Question: What form of chart is displayed?
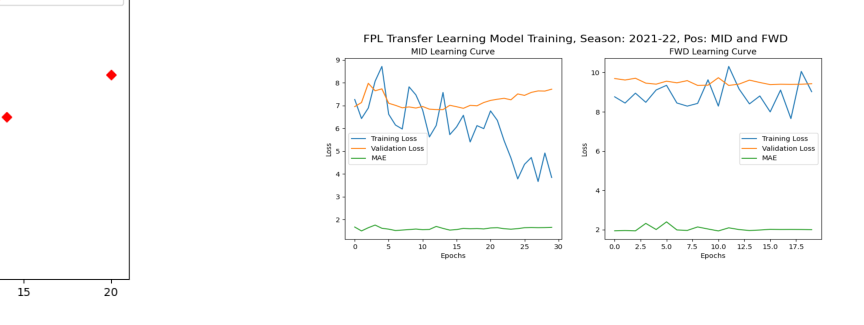
Answer: line